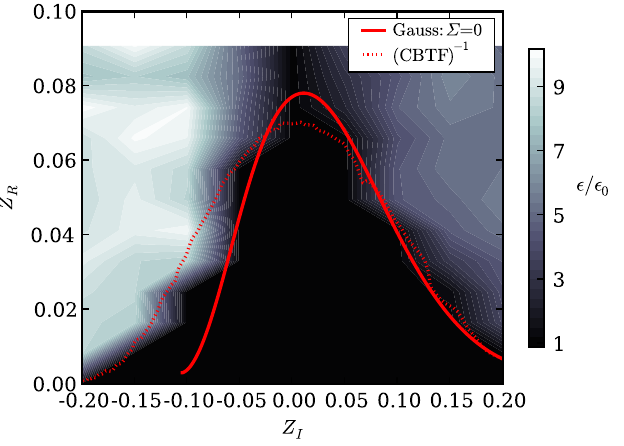
FIG. 10. (Color) Simulation scan of the stability boundary in the normalized impedance plane for a double rf wave and no space charge ( (cid:1) (cid:7) 0 ). The bunch length of the initially matched (cid:7) 60 (cid:12) . The solid red curve repre- Gaussian distribution is (cid:1) m FIG. 8. (Color) Snapshot of the phase space distribution close to sents the stability boundary obtained from the dispersion relation (cid:7) (cid:1) 0 : 2 , Z (cid:7) 0 : 02 , (cid:1) (cid:7) 0 : 1 , and the stability boundary for Z equation (28) for (cid:1) (cid:7) 0 . The dotted red curve represents the I R (cid:7) 60 (cid:12) . (cid:1) stability boundary obtained from the CBTF (see Sec. m